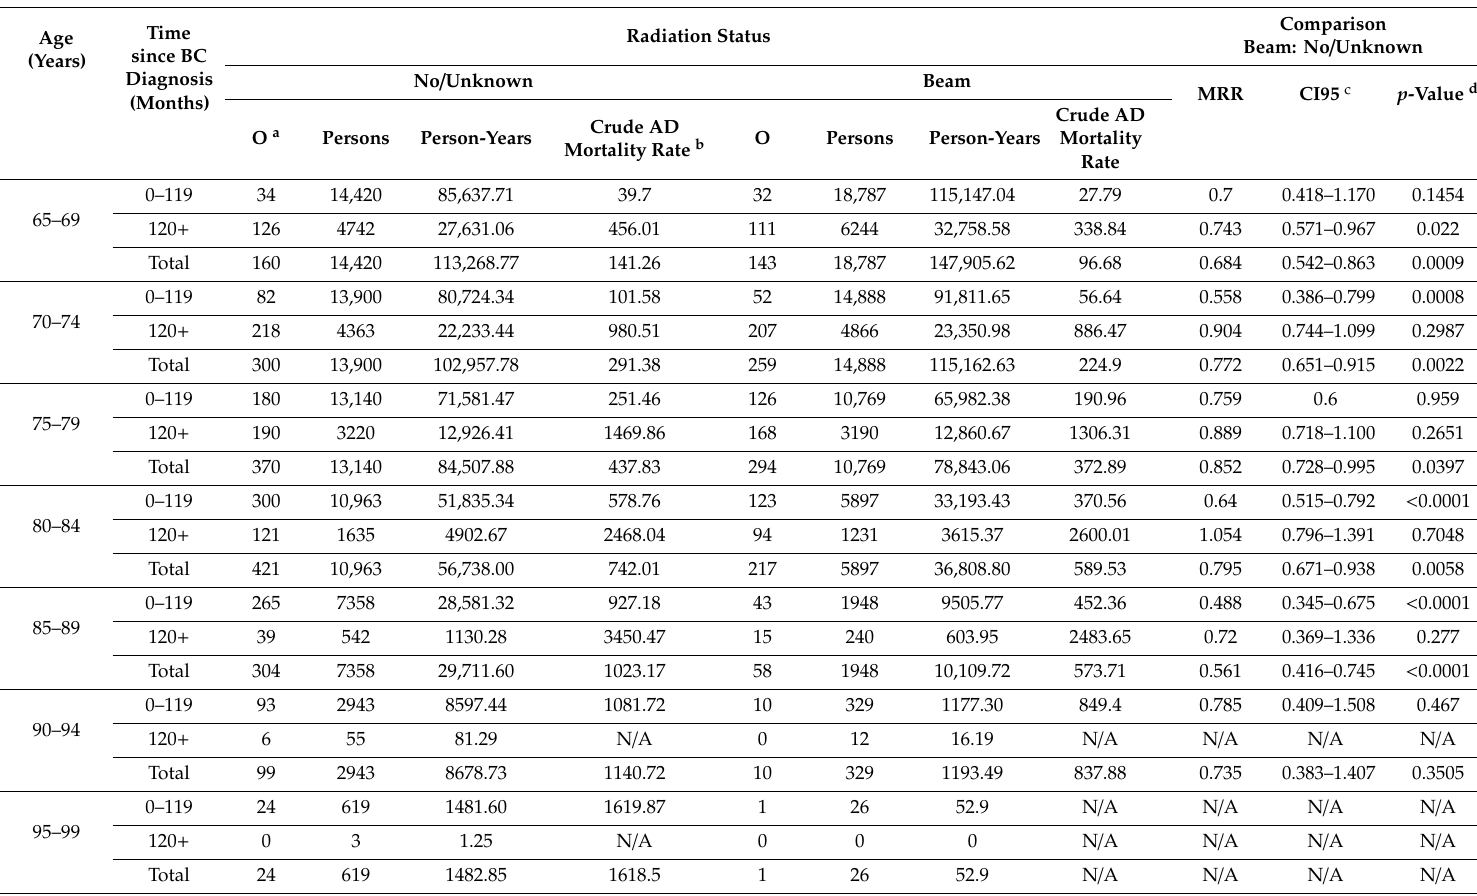
Table 4. Crude Alzheimer’s disease mortality rates and mortality rate ratios (MRR) for breast cancer patients from SEER 13 for di ff erent radiation therapy statuses. Mortality rates and MRRs were not calculated for subgroups with O <